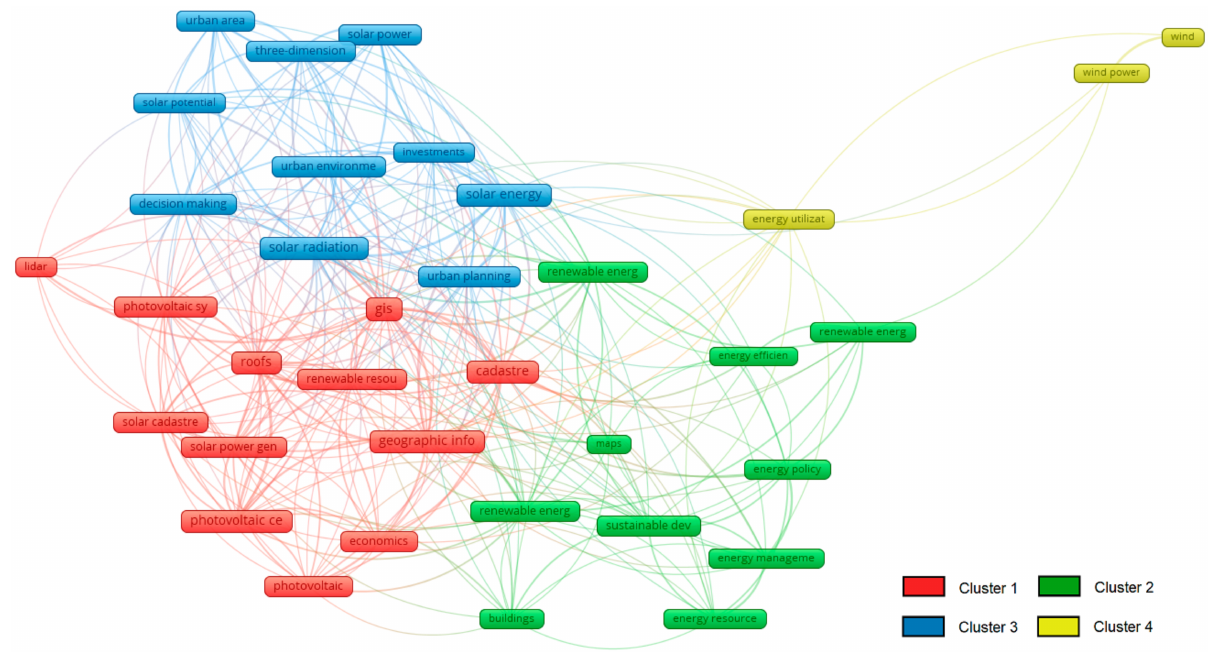
Figure 5. Keyword network from Scopus. Source: own